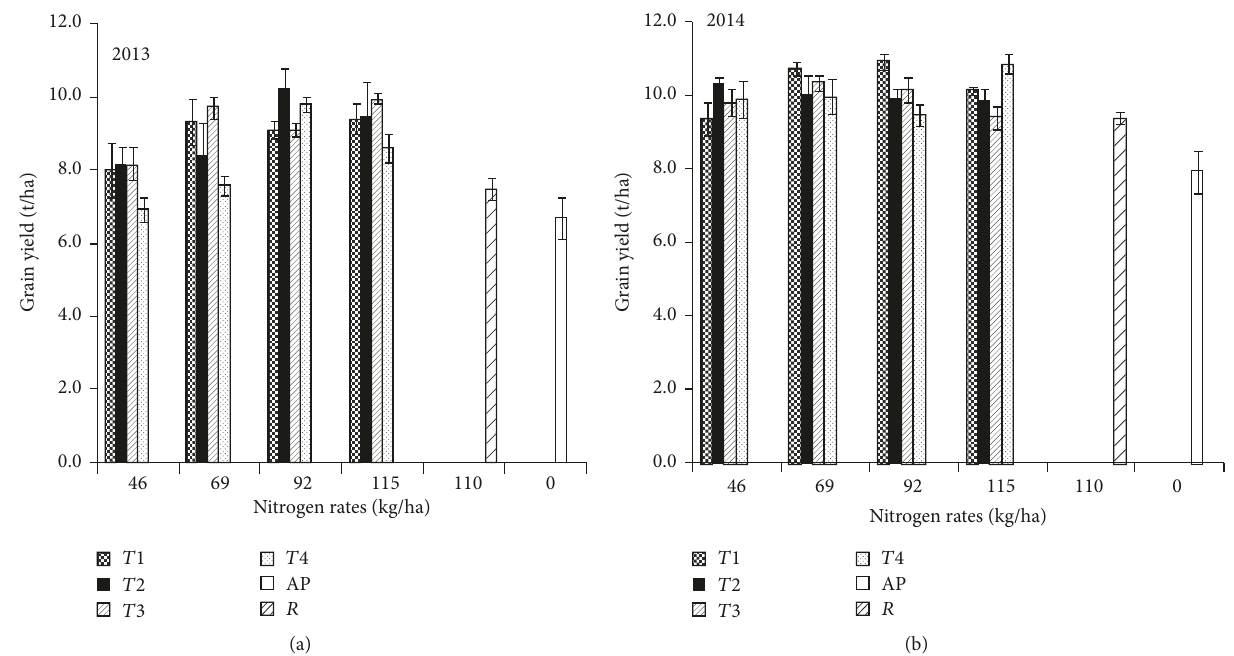
Figure 6: The effect of N rate and time of application on grain yield of maize in the 2013 and 2014 cropping seasons at Bako, Western Ethiopia.